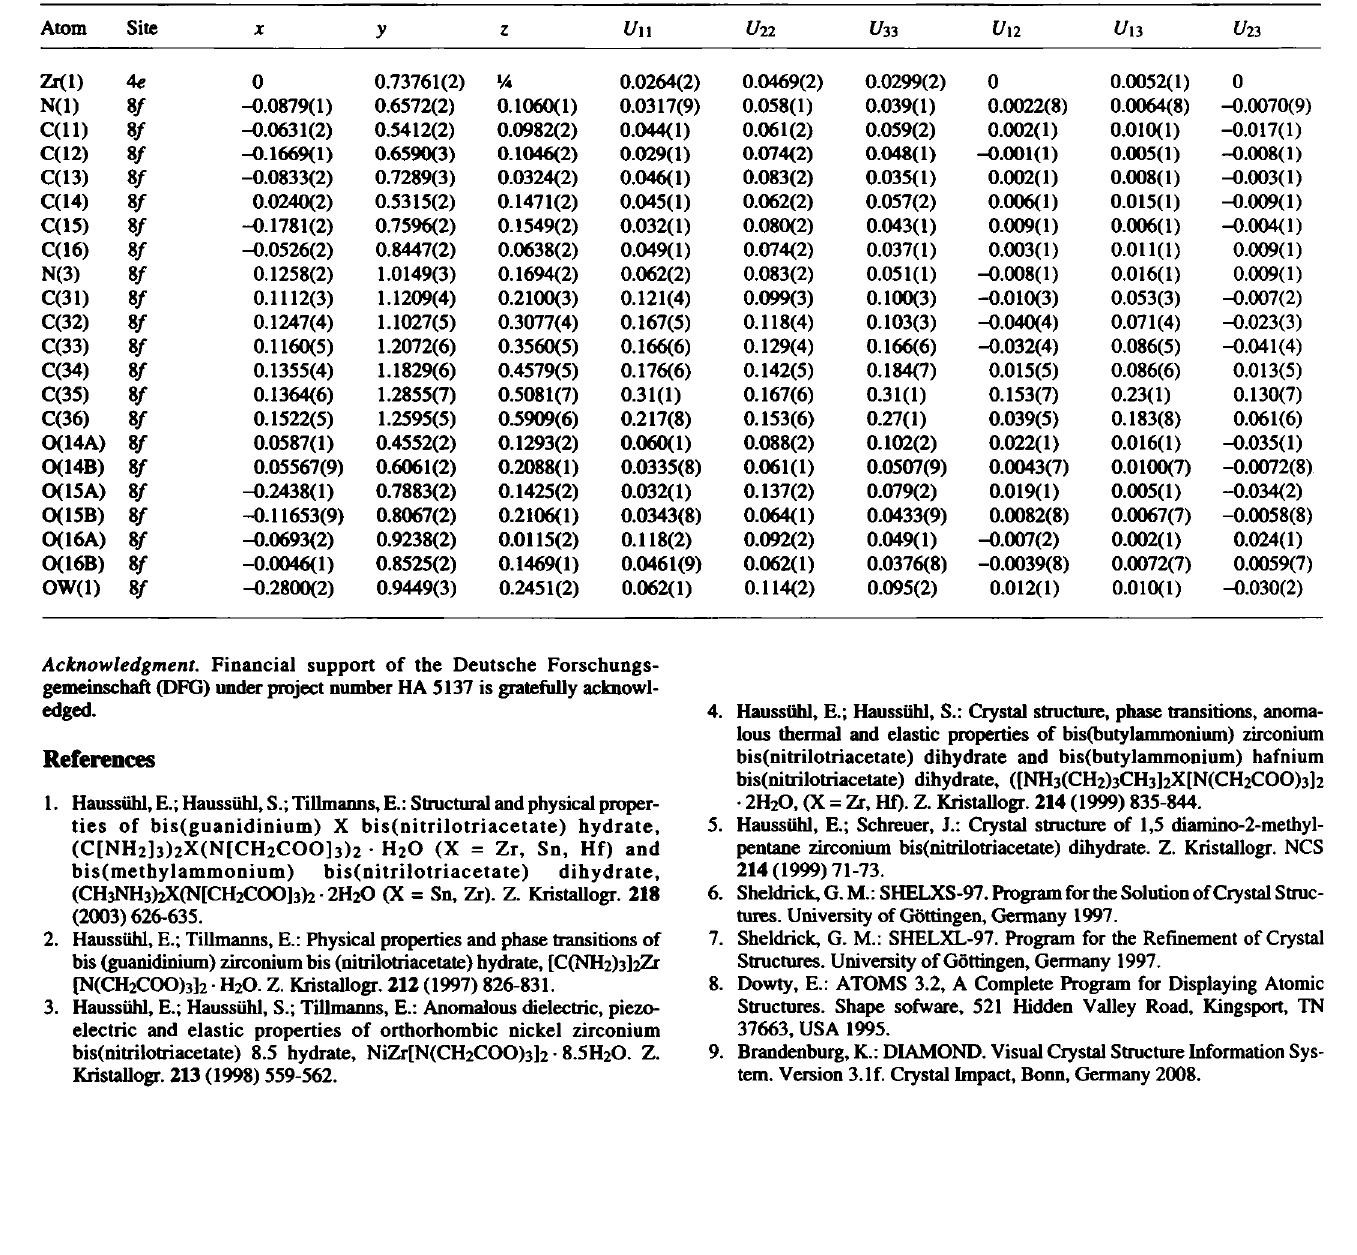
Table 3. Atomic coordinates and displacement parameters (in A 2